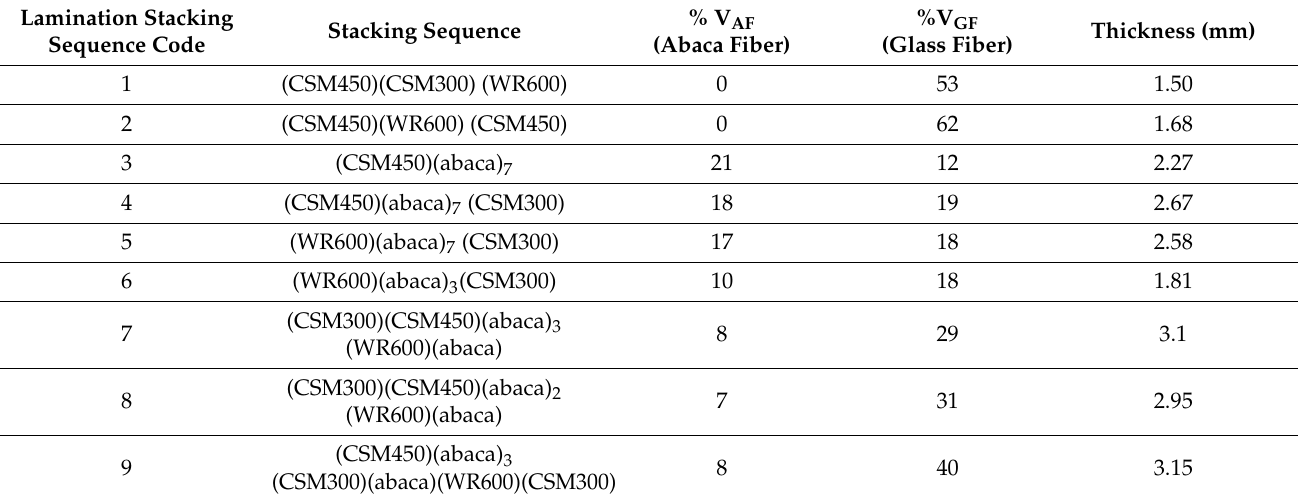
Table 1. Lamination stacking